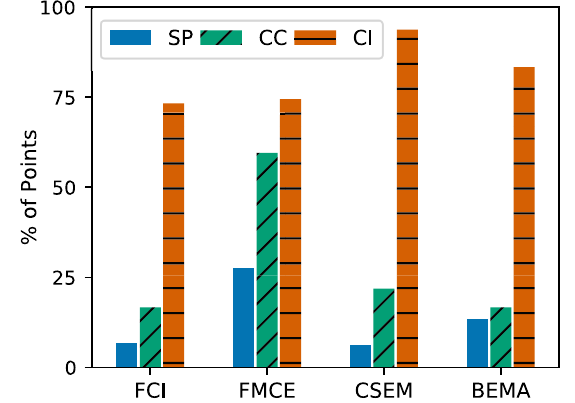
FIG. 2. Percentage of points for each concept inventory assigned to items that have the potential to elicit evidence of a scientific practice (SP), crosscutting concept (CC), or core idea